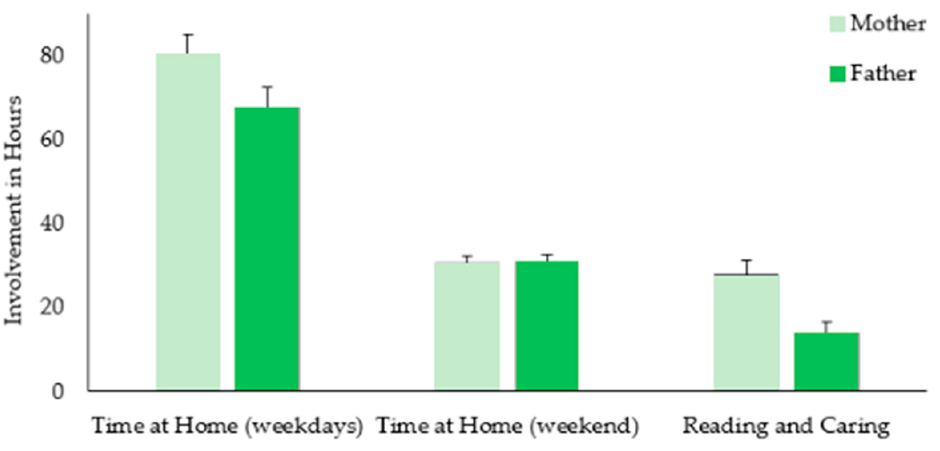
Figure 3. Self-reported parental involvement by mothers and fathers (means and